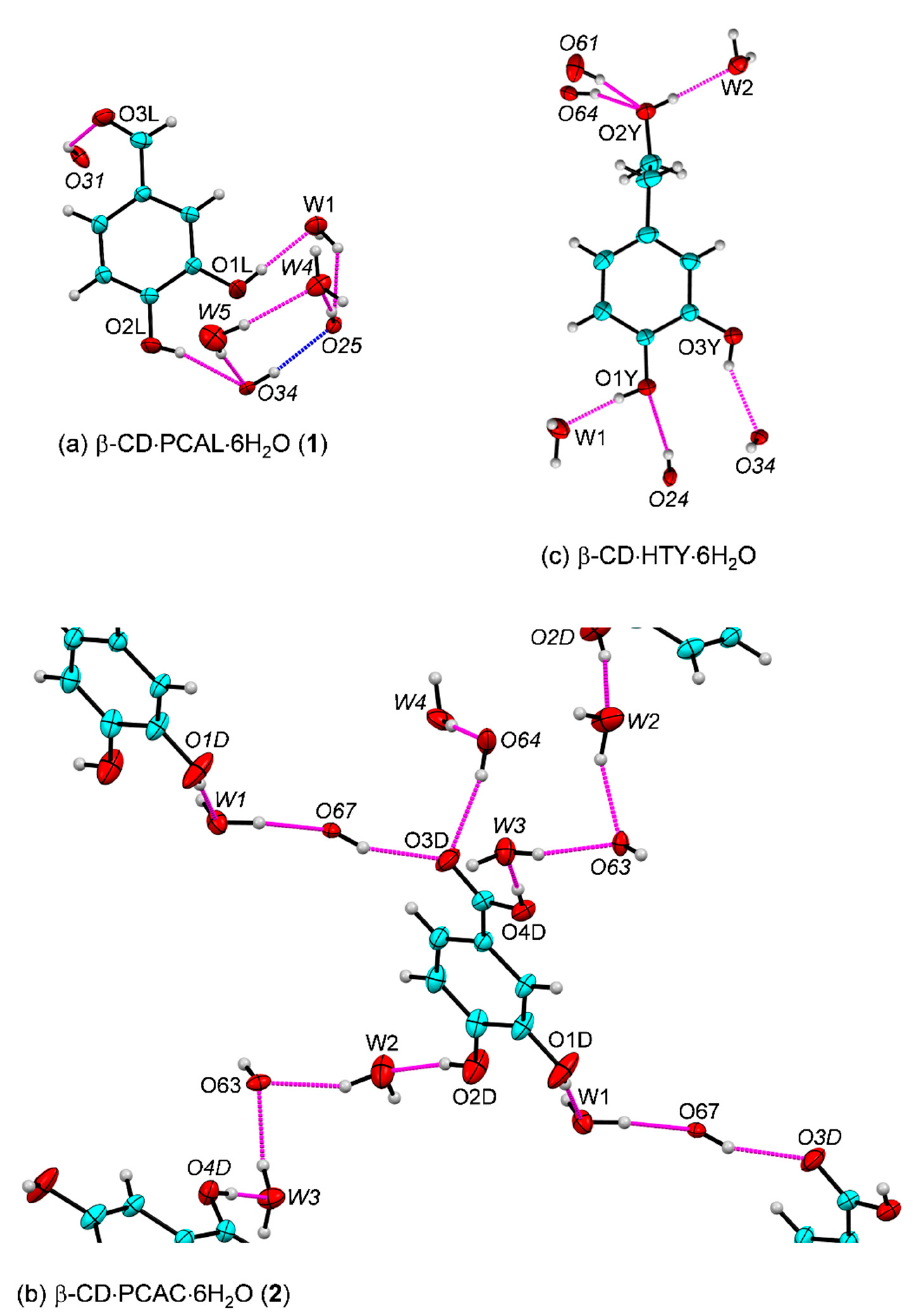
Figure 5. Intermolecular O – H ⋯ O hydrogen bonds ( magenta lines ) in the β - CD encapsulation of ( a ) PCAL, 1 and ( b ) PCAC, 2 . ( c ) The inclusion complex of β -CD·HTY·6H 2 O is shown for comparison (adapted from [35]) . Names in italics indicate molecules / groups of the adjacent asymmetric units; see also Figure 4 and Table 2 . In 1 , the intramolecular O34 – H···O25 H-bond stabilizing the round β -CD structure (blue line) is supported by the water network. In 2 , PCAC molecules embedded in the neighboring β -CD cavities are linked via bridging water molecules and β -CD O6 – H groups. The β -CD cavities accommodating the PCAL and PCAC molecules are omitted for clarity. The ORTEP diagrams are drawn with 30 % probability level .